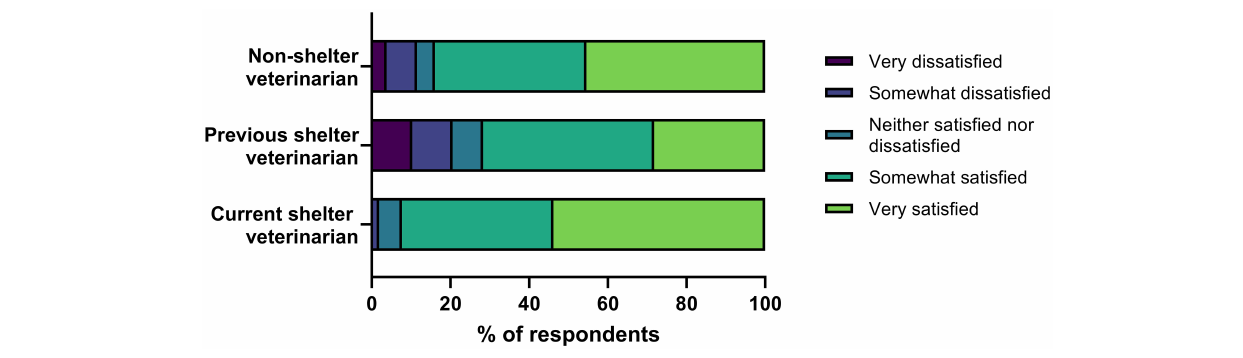
FIGURE 1 | Job satisfaction in veterinary